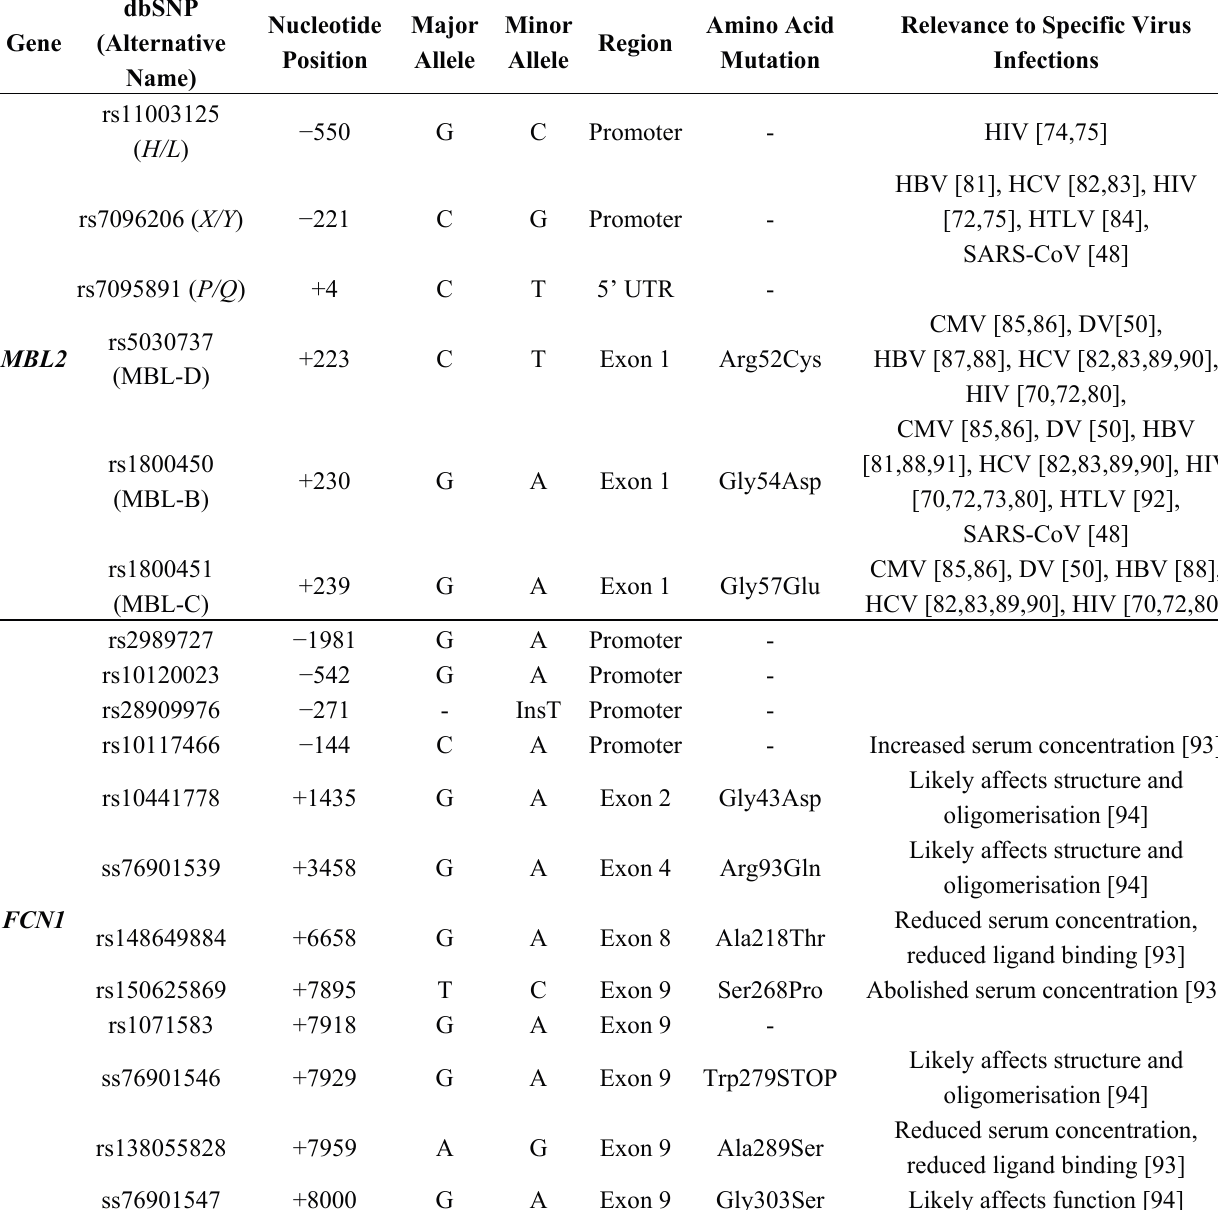
Table 1. Single nucleotide polymorphisms of the MBL2 , FCN and CD209 genes with associations with virus infections. del = deletion; ins = insertion. +1 represents the A of the ATG translation start site for all genes except MBL2, where +1 represents the transcription start site, to comply with